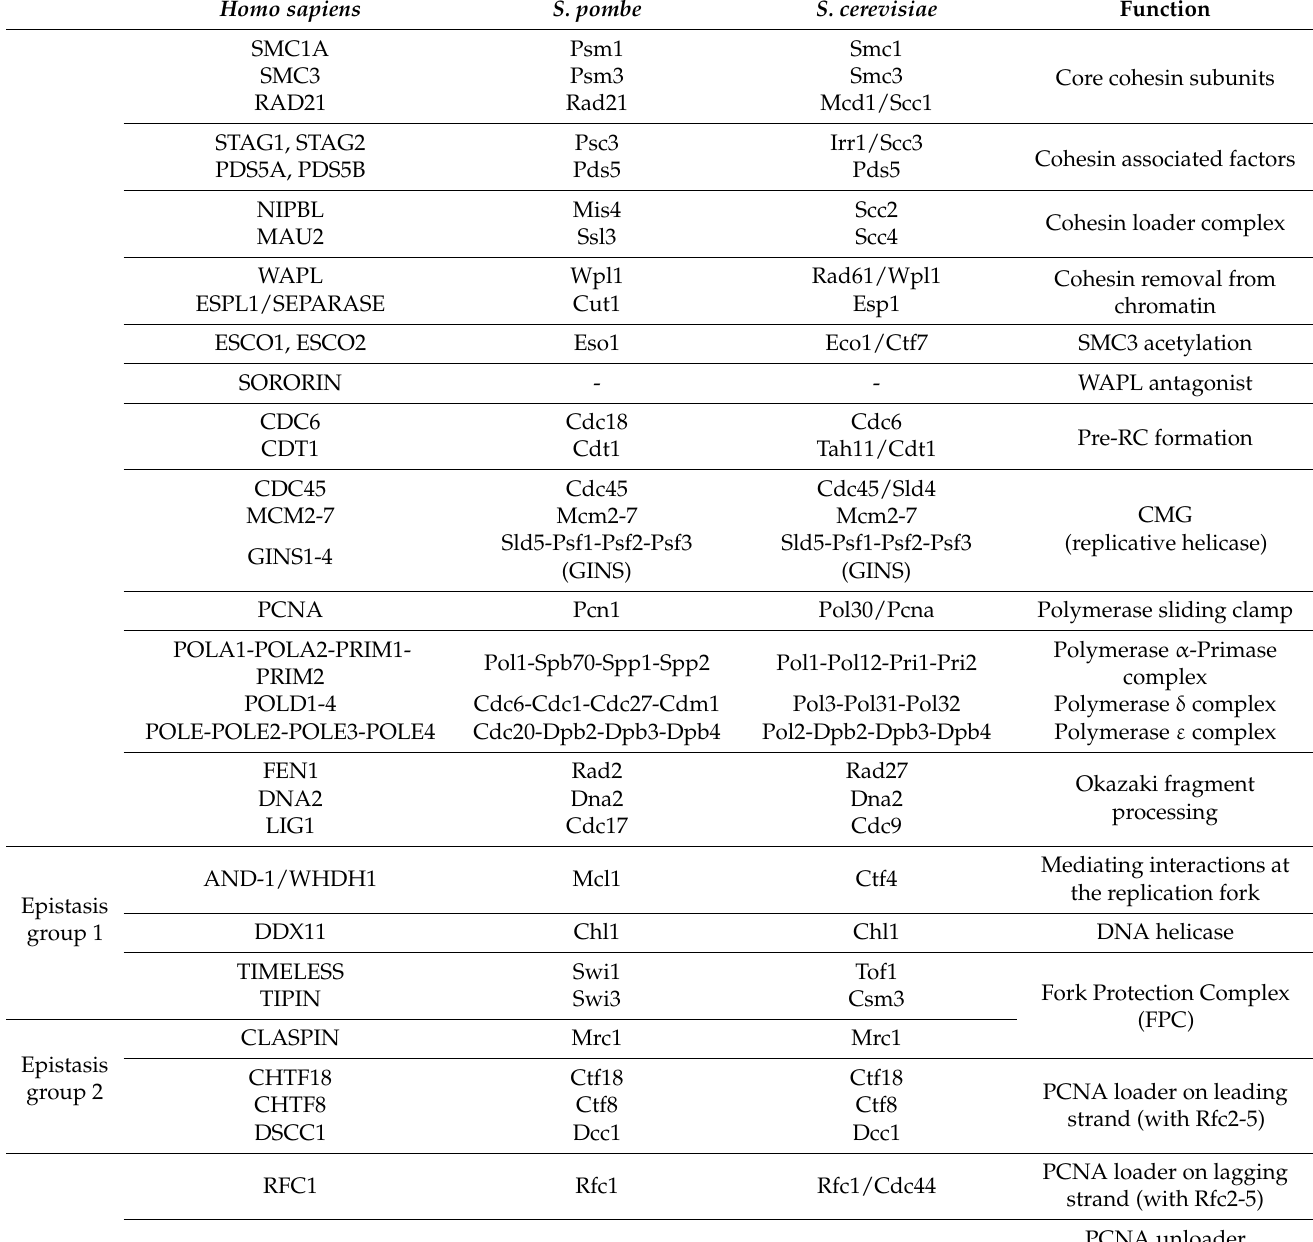
Table 1. Key factors in sister chromatid cohesion and DNA replication. Homo